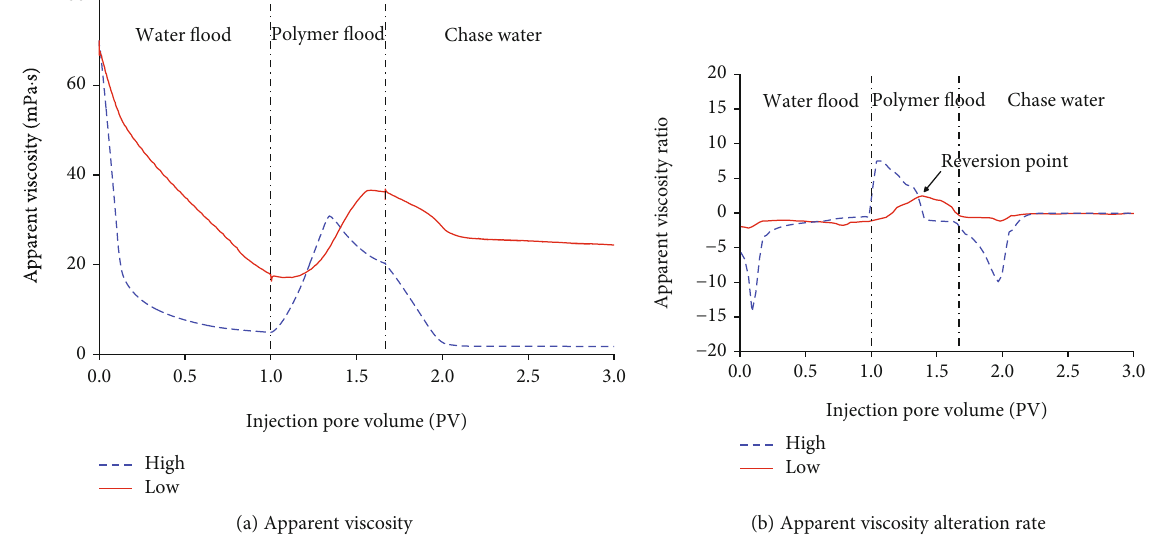
Figure 5: Apparent viscosity and its alteration rate of each layer as a function of the injection pore volume.